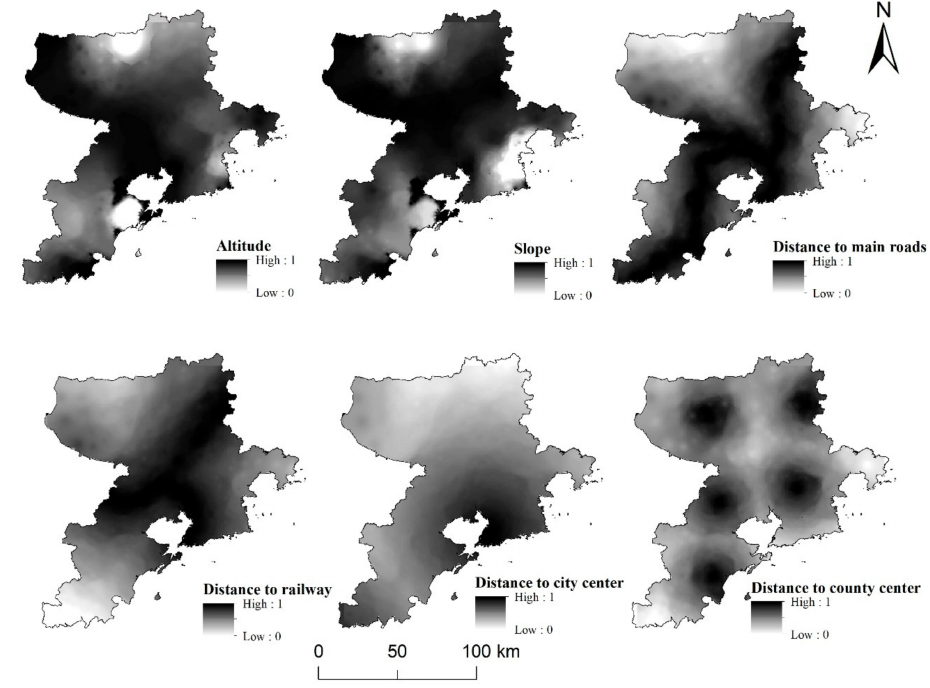
Figure 5. Standardized spatial distribution of three-dimensional location factors.